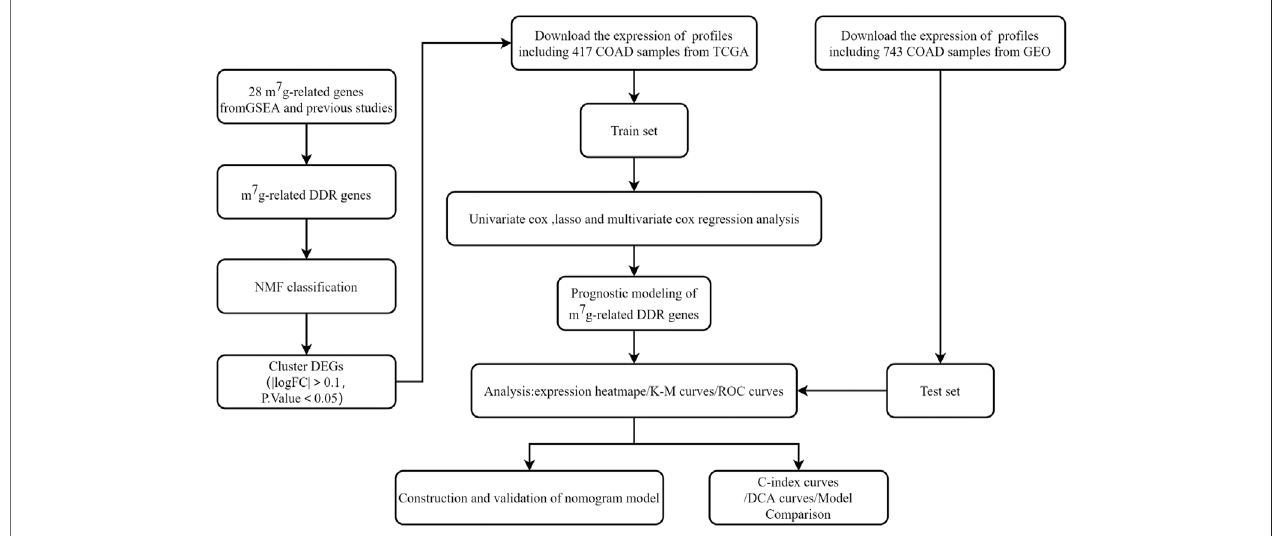
FIGURE 1 | The fl owchart showing the design to establish and validate the prognostic signature in the study.